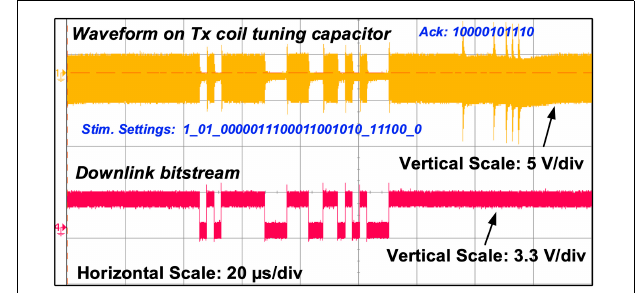
FIGURE 9 | Measured carrier waveform on the Tx tuning capacitor showing both OOK and PPSK modulation, alongside the measured downlink